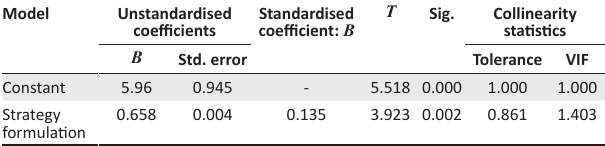
TABLE 6: Strategy formulation and financial performance regression weights model.